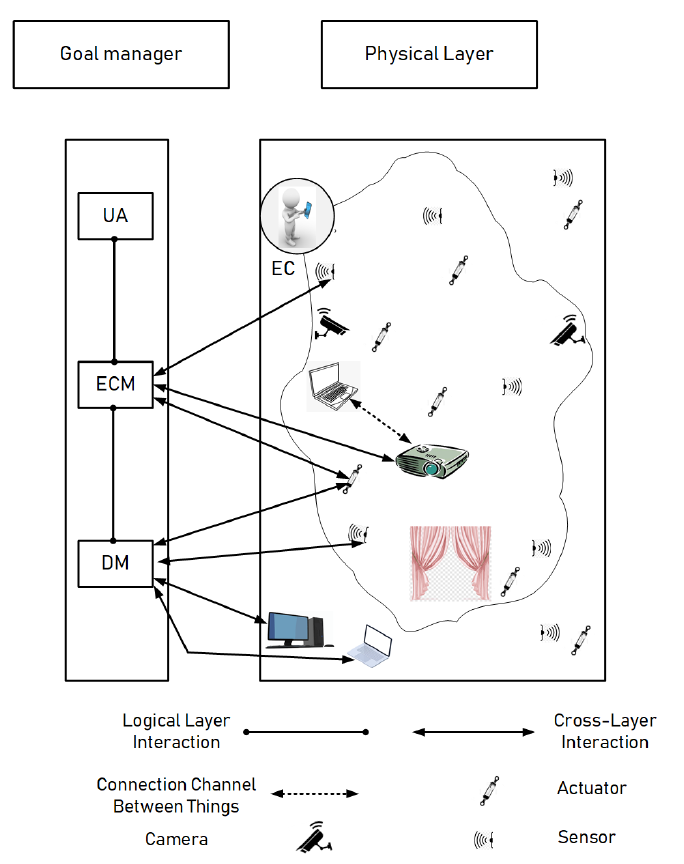
Figure 3. Illustration of the physical and logical layers of an